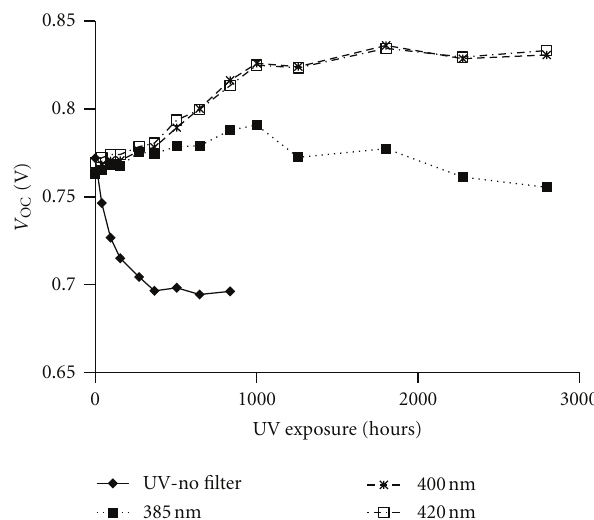
Figure 9: V OC data for cells filtered at 385 nm, 400nm, and 420 nm over the exposure period compared to cells exposed without a UV filter.